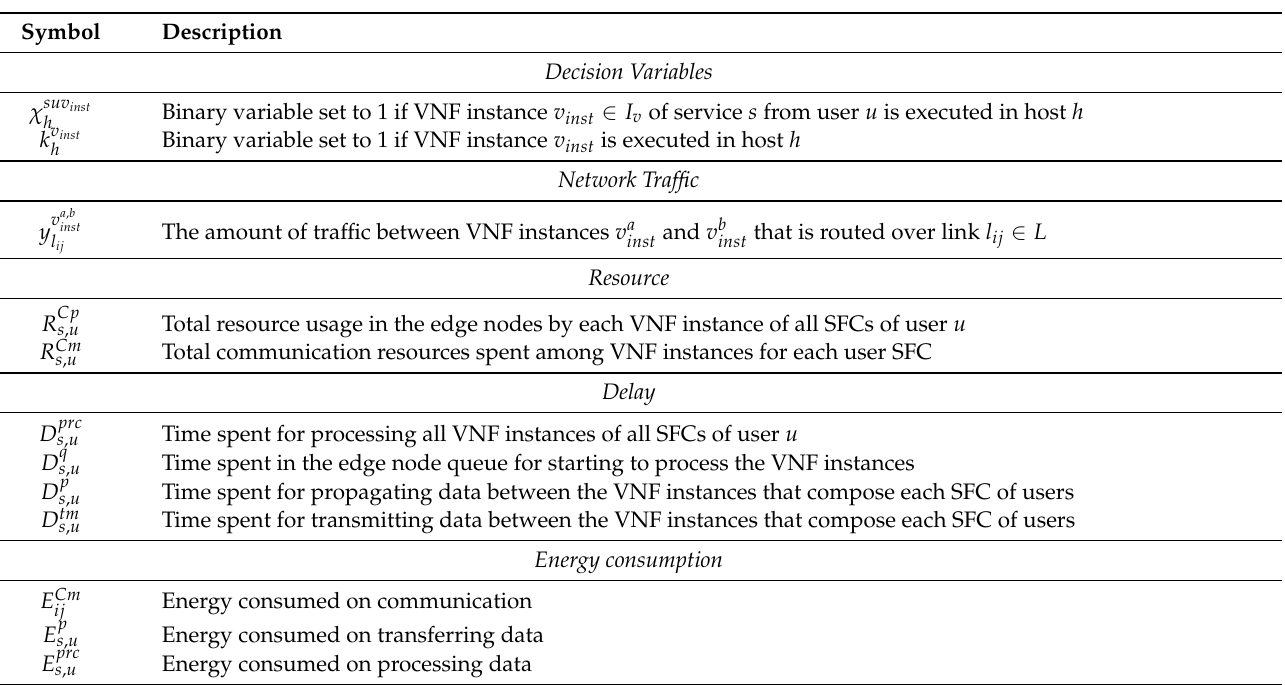
Table 4. ILP Symbols and